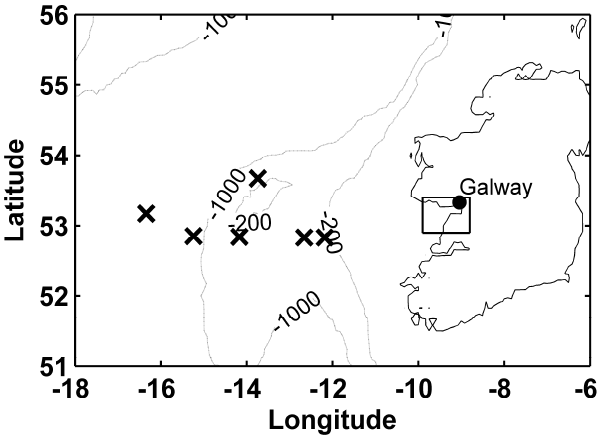
Figure 2. Map of Ireland and the North Atlantic, the rectangle contains the survey area in Galway Bay. The contours at 200 and 1,000 m depth indicate the Porcupine Bank, and the x symbols station locations in the Southern Rockall